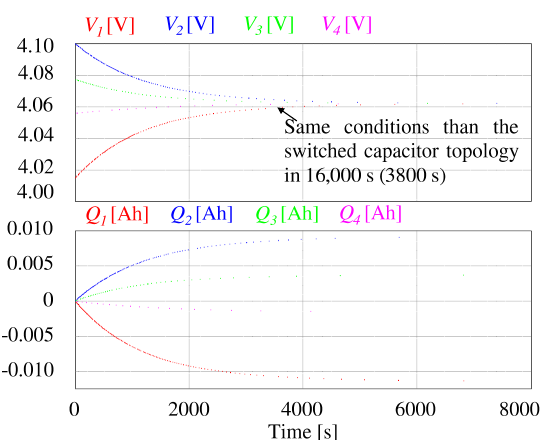
Figure 17. Equalization of a four-cell battery bank using the triple-tiered switched capacitor scheme.